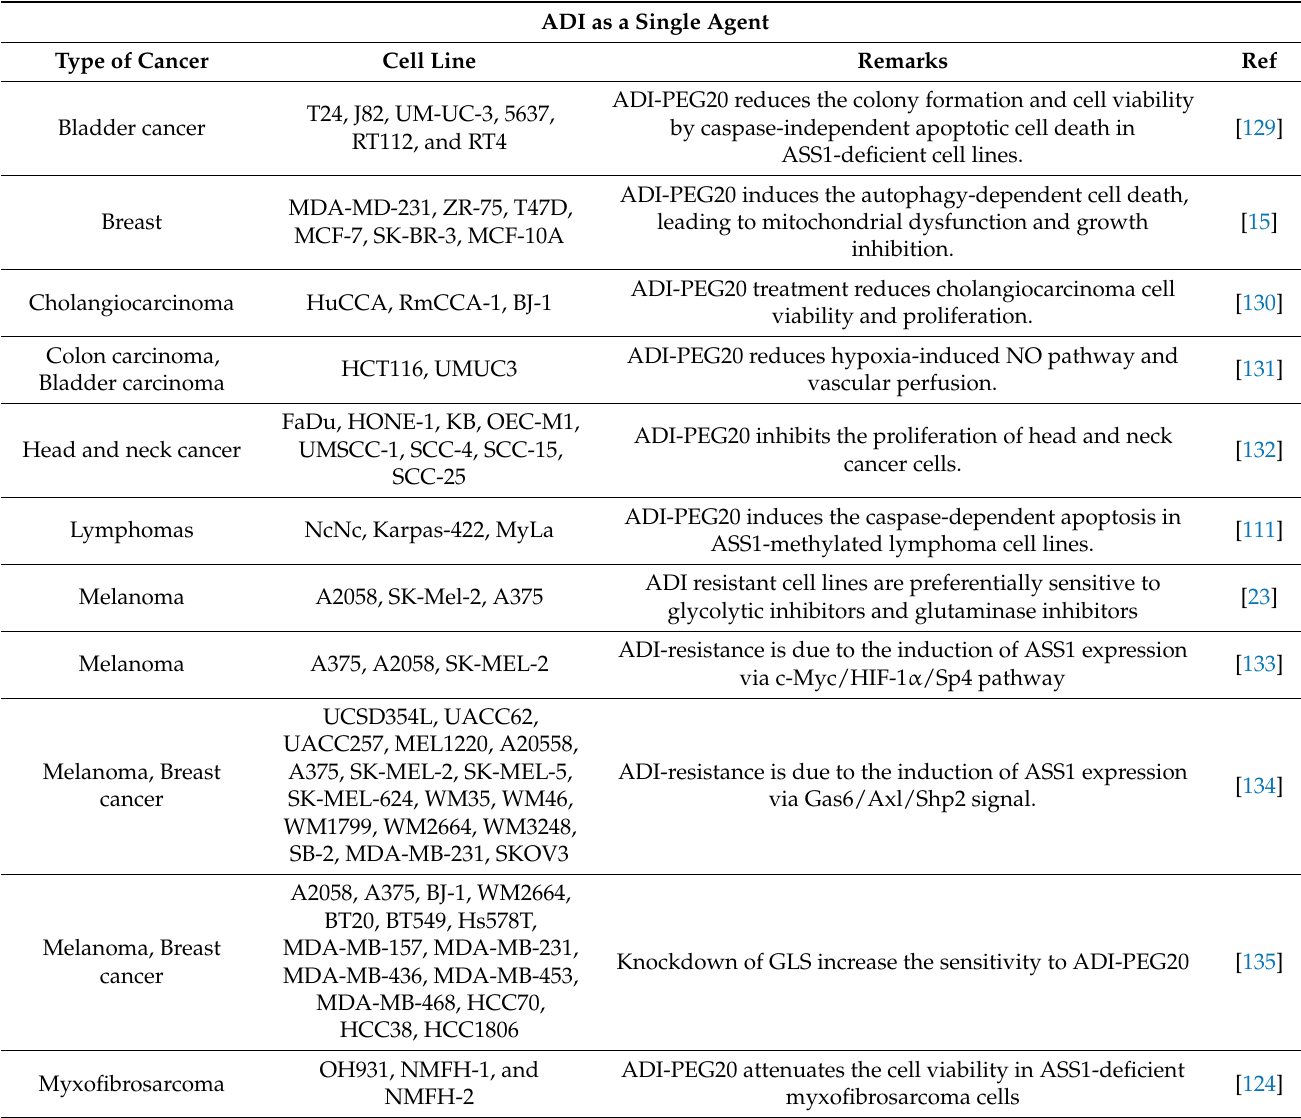
Table 3. ADI preclinical